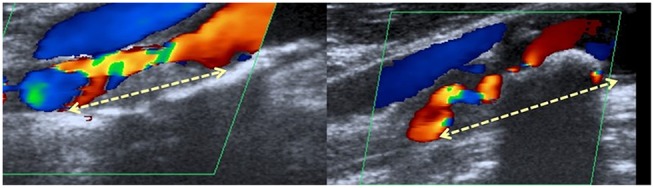
Assessment of the length of internal carotid artery stenosis. A representative example of a duplex scan (B-mode).The length of stenosis was measured from the most proximal to the most distal stenotic area (indicated by a dashed yellow double arrowhead).